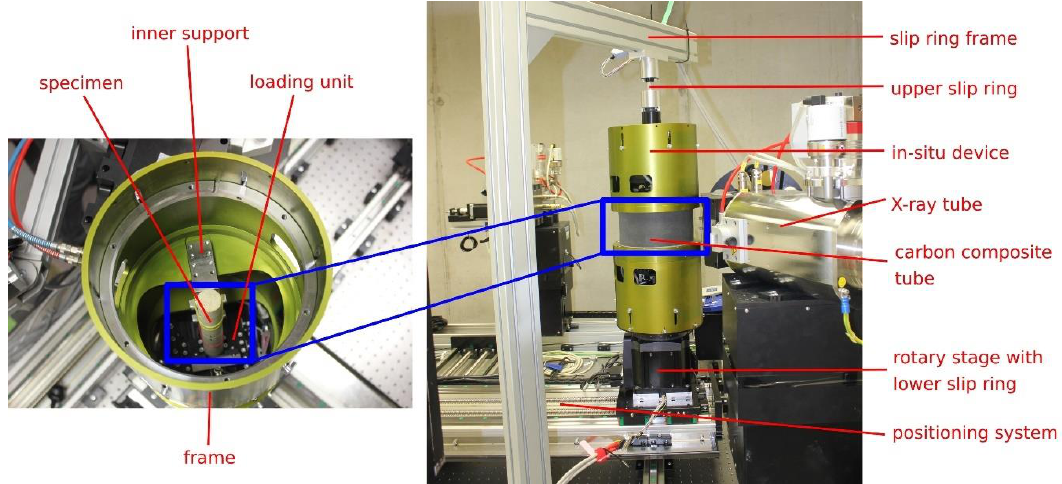
Figure 5. The in-situ loading device attached to the rotary stage of the X-ray scanner.